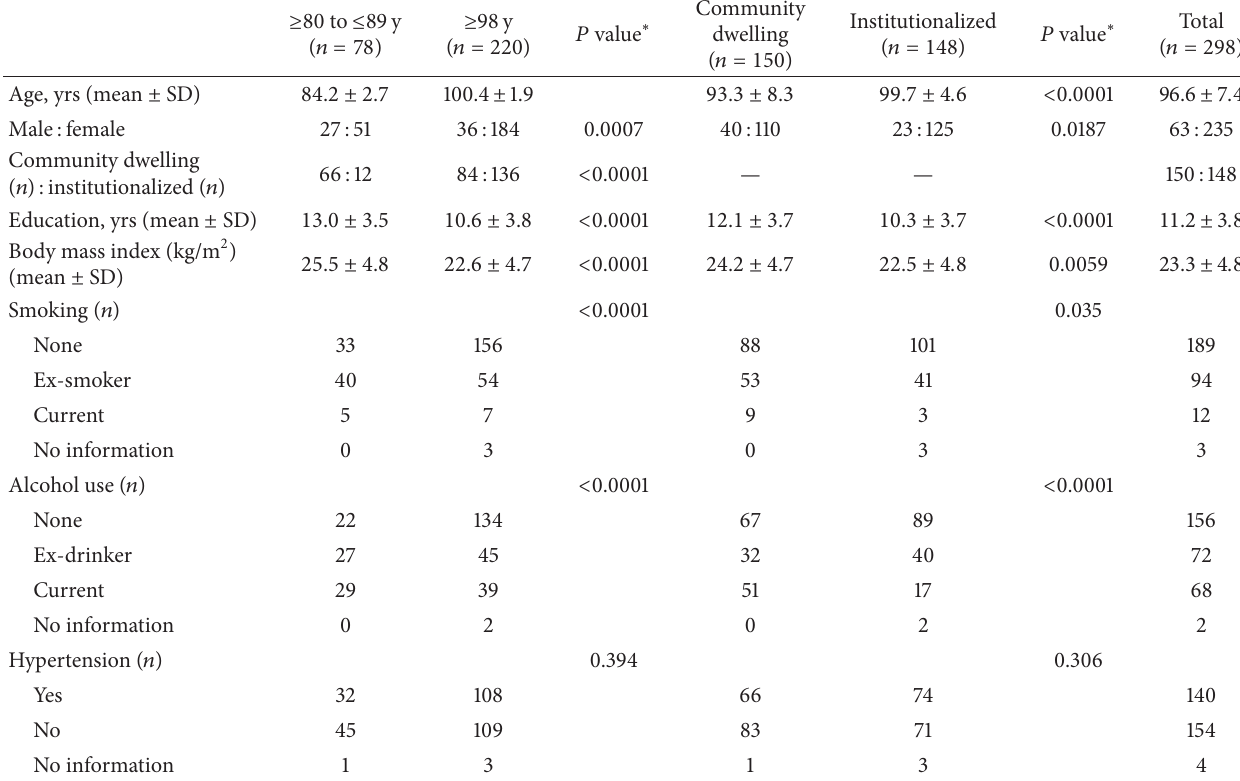
Table 1: Subject